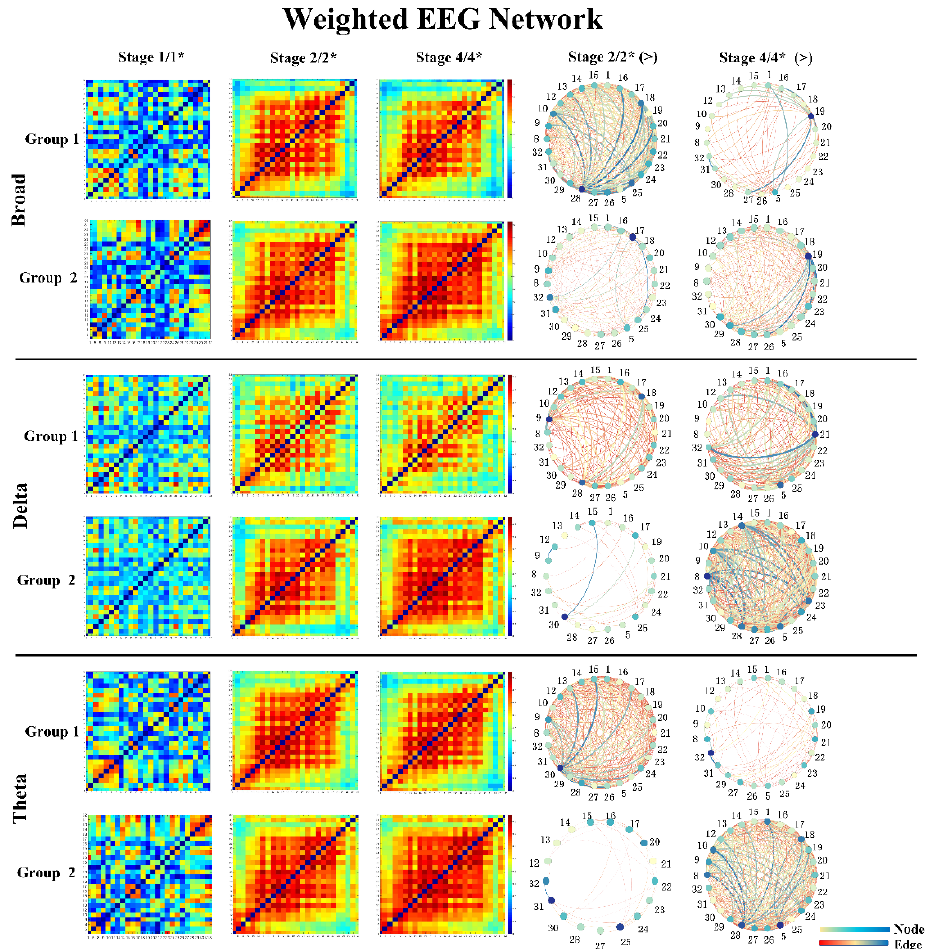
Figure 10. Mean phase-locking value (PLV) for all filtered frequency bands (delta 0.1–4 Hz, theta 4– 8 Hz, alpha 8–13 Hz, beta 13–30 Hz and gamma 30–48 Hz) and the broad-filtered signal (0.1–48 Hz). ( A ) Within-group comparisons of the mean PLV at the different stages; ▲ represents a significant difference between Stage 1/1* and Stage 2/2* ( p < 0.05). ( B ) Between-group comparisons of the mean PLV between Group 1 and Group 2 (‘Sonication’ represents Group 1 and ‘Control’ represents Group 2). * indicates significance ( p < 0.05).